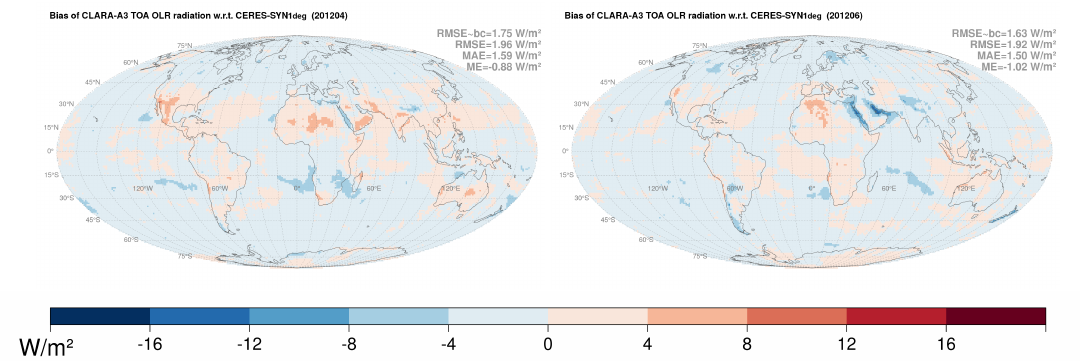
Figure 8. Monthly mean OLR difference with respect to CERES Synoptic 1 ◦ latitude 1 ◦ longitude gridded (SYN1deg) for April 2012 ( left ) and June 2012 ( right ) when all four satellites (METOP-A, NOAA-15, NOAA-17, NOAA-19) are processed.